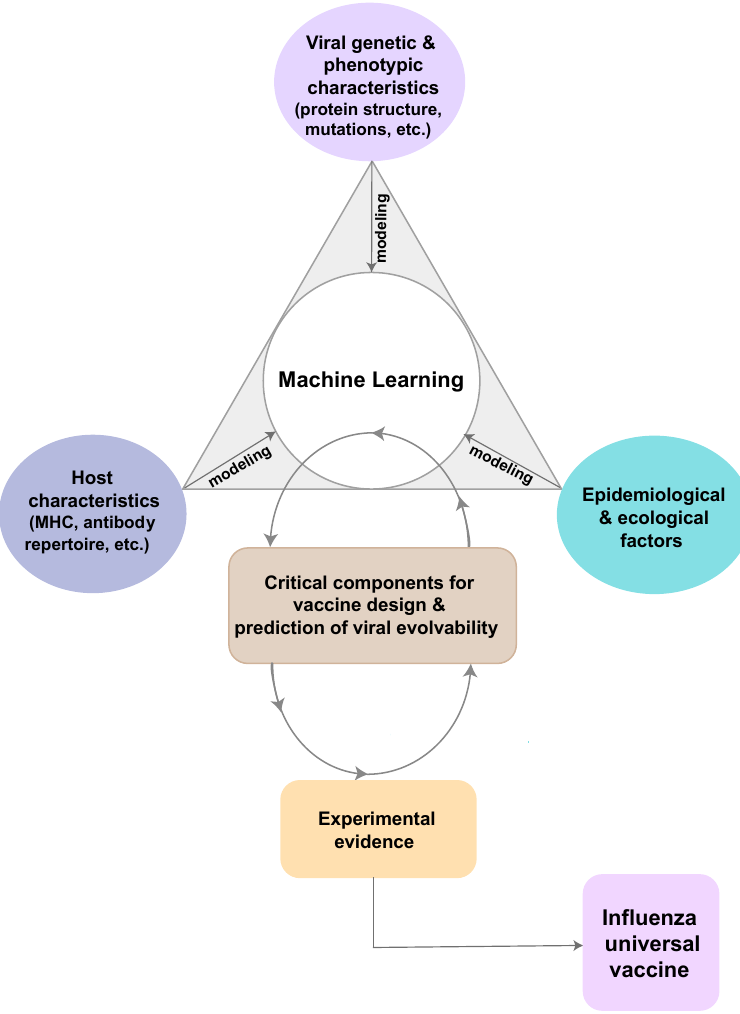
Figure 1. Framework of potential novel computational design. The summarized potential approaches combine the epidemiologic triad of infectious diseases. From host perspective, data on host characteristics are modeled to understand the susceptibility and immune response to influenza viruses by studying the host immunogenetics, for example, the antibody repertoire analysis or the human leukocyte antigen (HLA) structure analysis. From virus perspective, phylogenetic modeling is to understand the evolutionary history and patterns of viral genetic and phenotypic